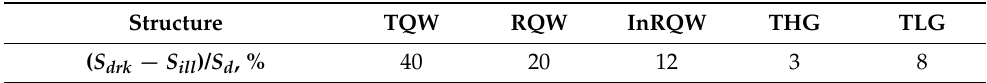
Figure 5. Dependence of voltage responsivity of the THG planar, asymmetrically necked MW diodes with different widths d of the neck. Microwave frequency is f = 30 GHz. Table 5. The relative change in voltage responsivity of different diodes as a result of their reaction to illumination. S drk is the responsivity in the dark, and S ill notes it under illumination.